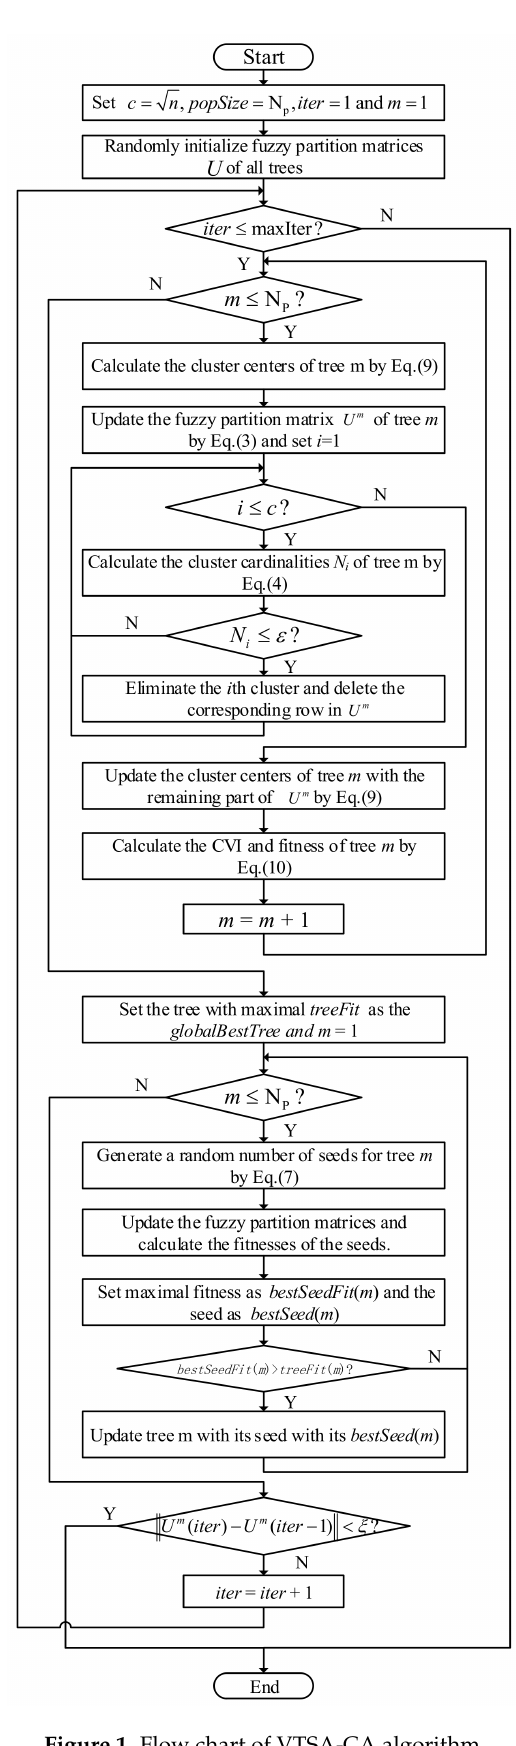
Figure 1. Flow chart of VTSA-CA